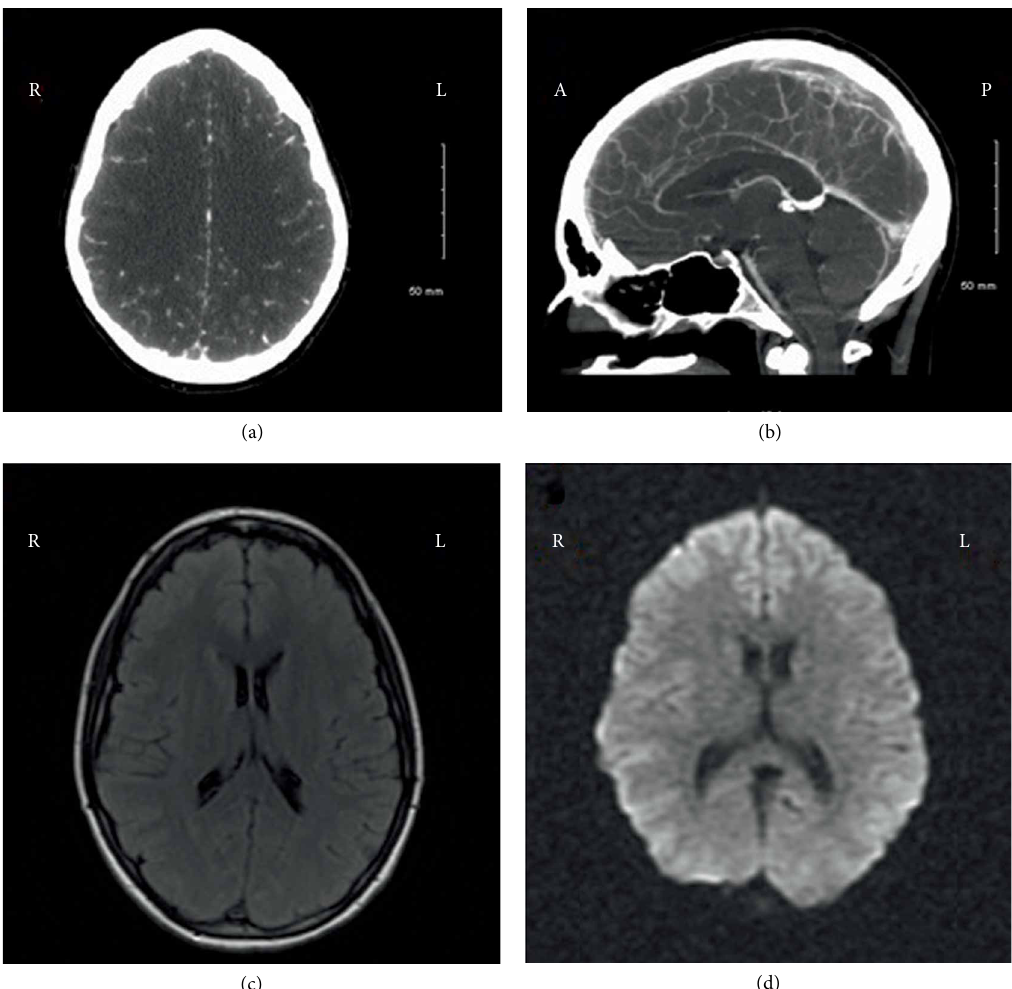
Figure 1: CTV and MRI showing extensive cerebral sinus thrombosis. (a) CT venogram. Axial view. Showing empty delta sign and thrombus in the superior sagittal sinus. (b) CT venogram. Sagittal view. Showing filling defect in the superior sagittal sinus consistent with thrombotic occlusion of superior sagittal sinus. (c) MRI brain T2 Fluid-attenuated Inversion Recovery (FLAIR). Axial view. Showing no parenchymal involvement. (d) MRI brain Diffusion weighted imaging (DWI). Axial view. Showing no acute ischemia or cytotoxic